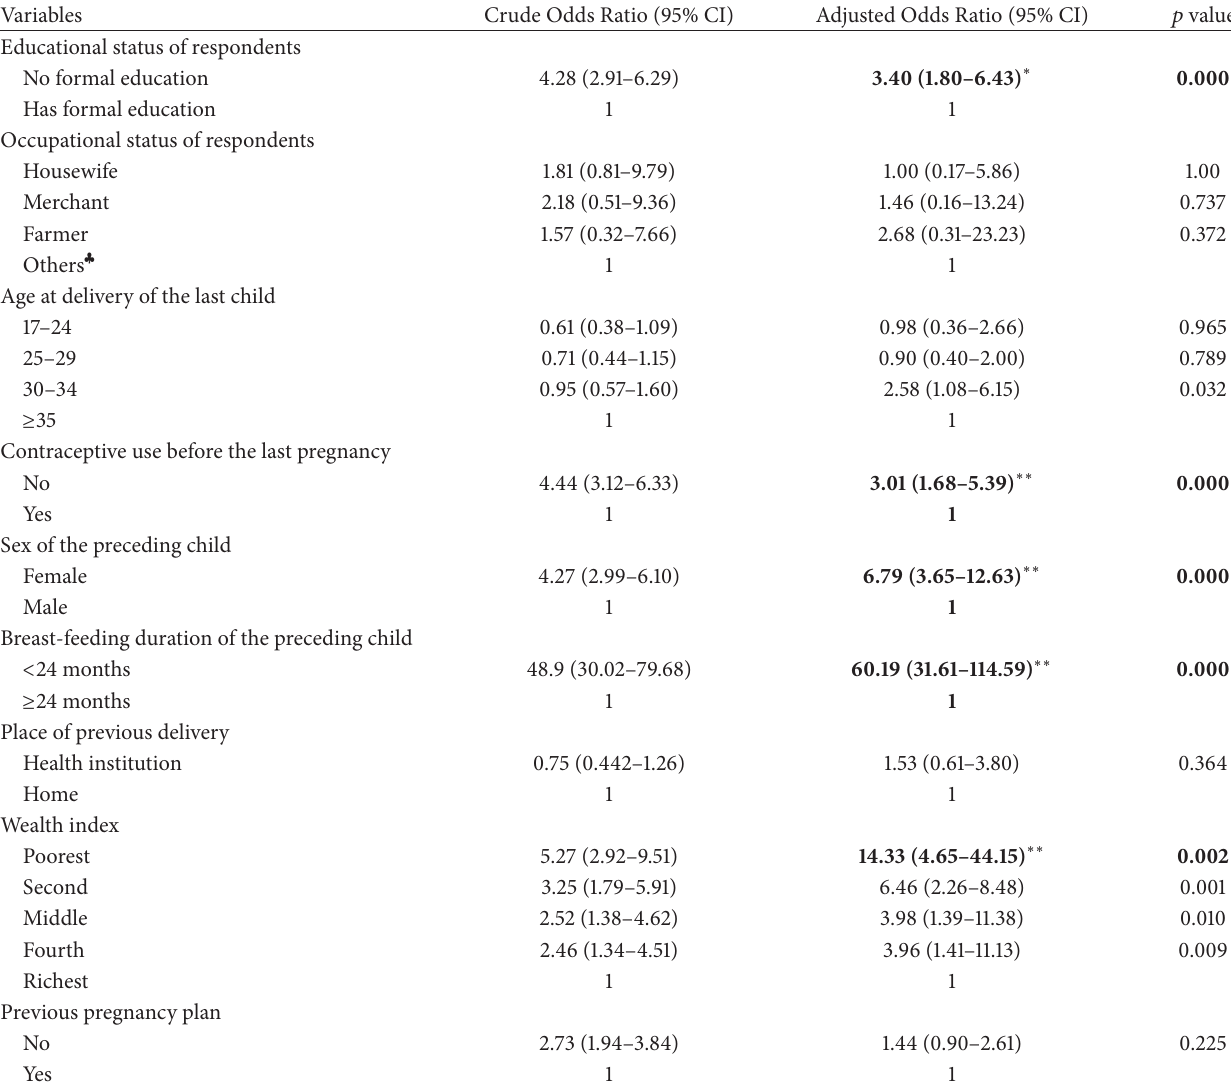
Table 3: Multivariate analysis of determinant factors among child-bearing age mothers in Arba Minch Zuria District, Gamo Gofa Zone, Ethiopia,